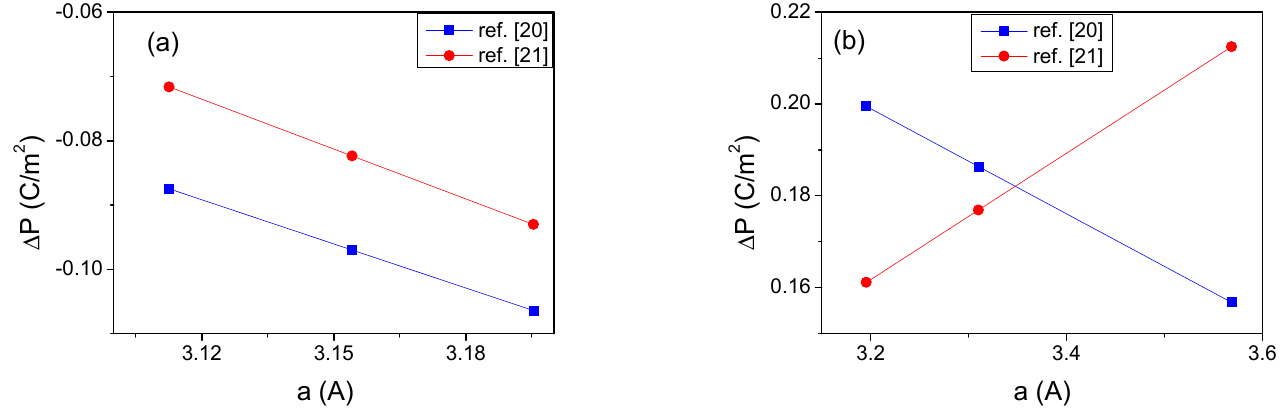
Figure 2. Polarization difference in function of the a lattice constants: ( a ) ∆ P = P InN − P GaN ; ( b ) ∆ P = P AlN − P GaN .